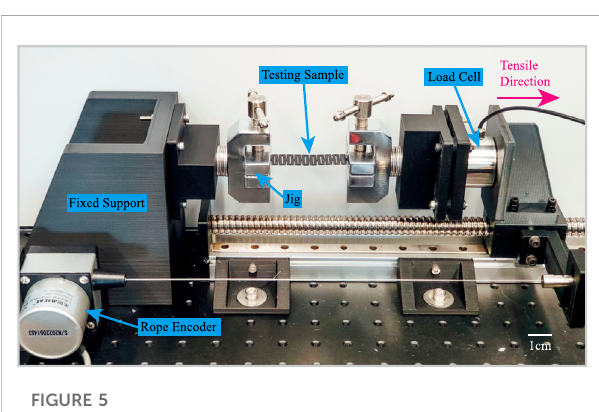
FIGURE 5 Experimental setup for spring stiffness